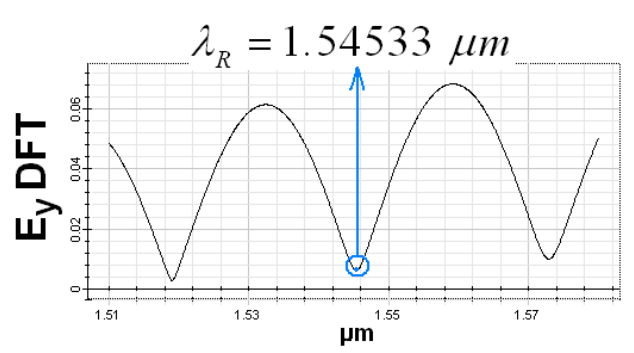
Figure 7 . Field component E